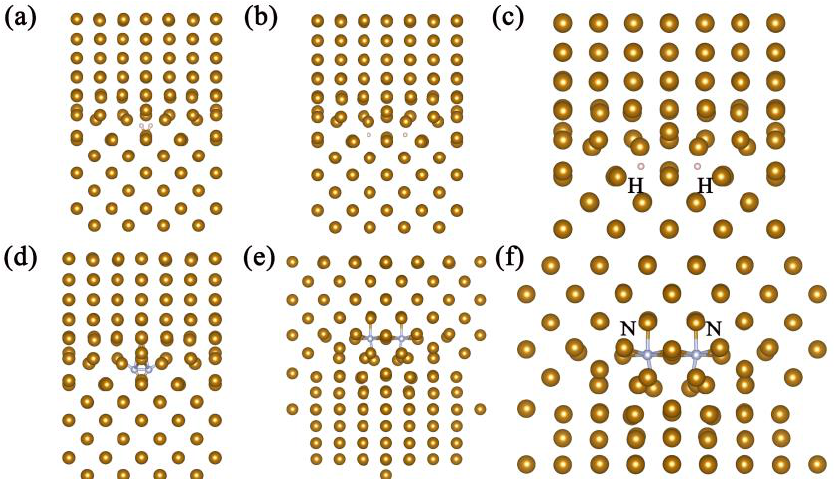
Figure 5. Model diagram before and after optimization. ( a – c ) The main view of the presence of two hydrogen atoms at the interface before optimization, and the main view and local enlargement after optimization, respectively. ( d – f ) The main view of the presence of two nitrogen atoms at the interface before optimization, and the main view and local enlargement after optimization, respectively.